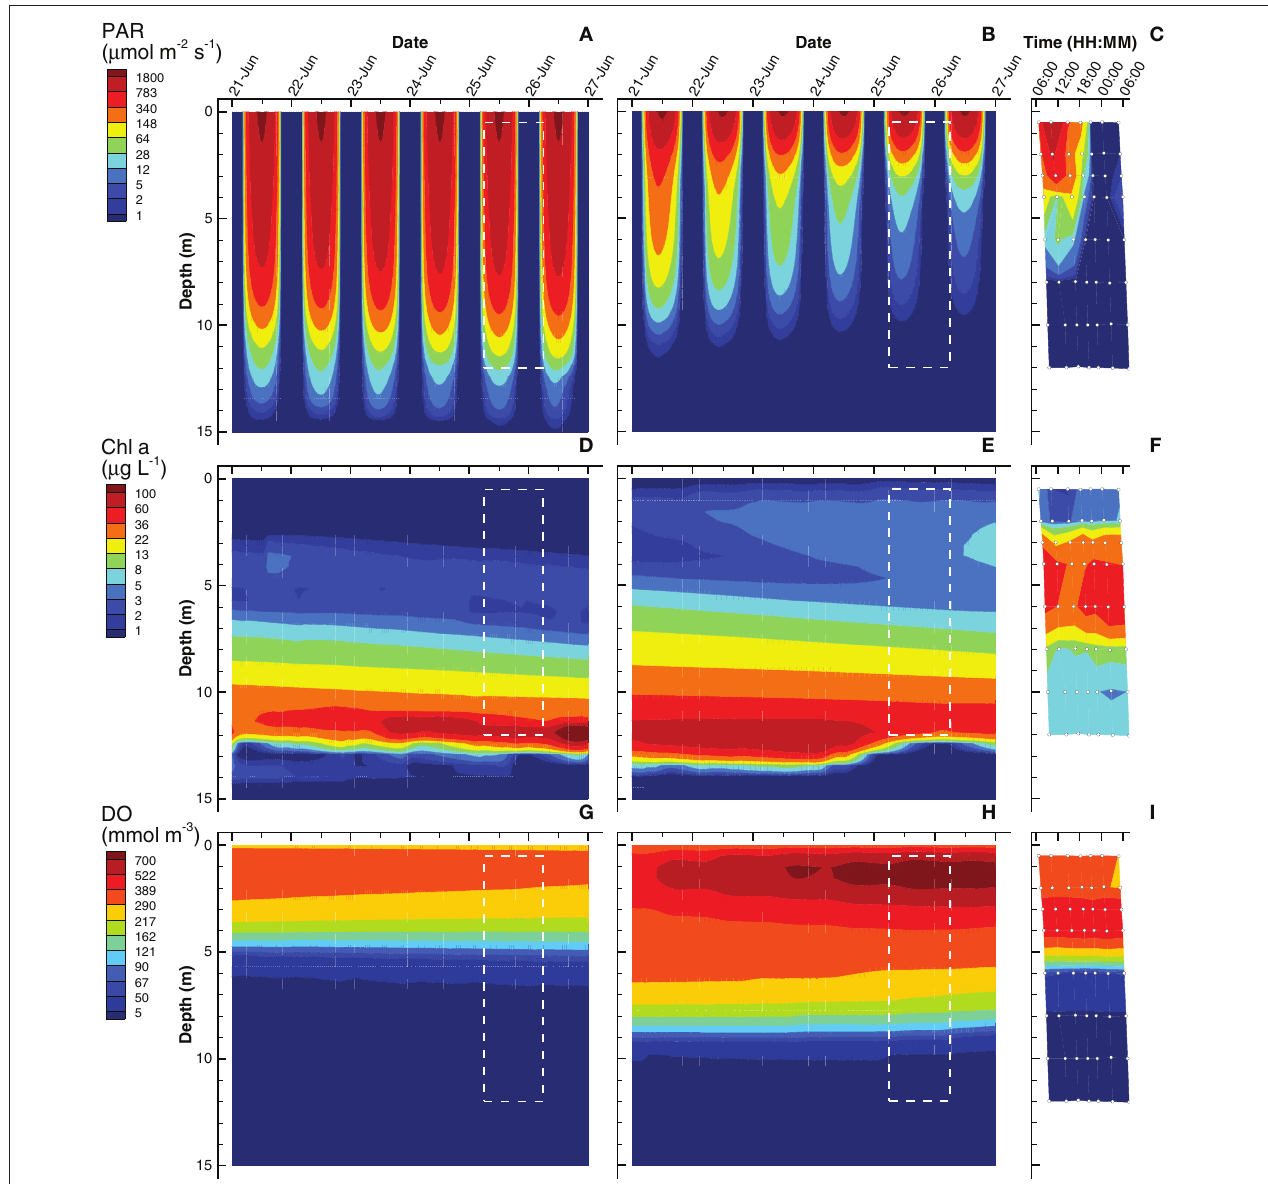
FIGURE 3 | Contour plots of photosynthetic active radiation (PAR) (A–C) , chlorophyll (Chl) a concentration (D–F) and dissolved oxygen (DO) (G–I) for six day simulations using short interval optimization (SIO) (left column), long interval optimization (LIO) (center column) and for observations collected from Siders Pond over a 24h period on Jun 25 to Jun 26 2015 (right column). Rectangle (dashed white lines) in simulation plots corresponds to time and depths where observations are comparable (i.e., Jun 25/26, 0.5 to 12m). Actual observations are shown as white circles with black perimeters (see also Figure 2 ).